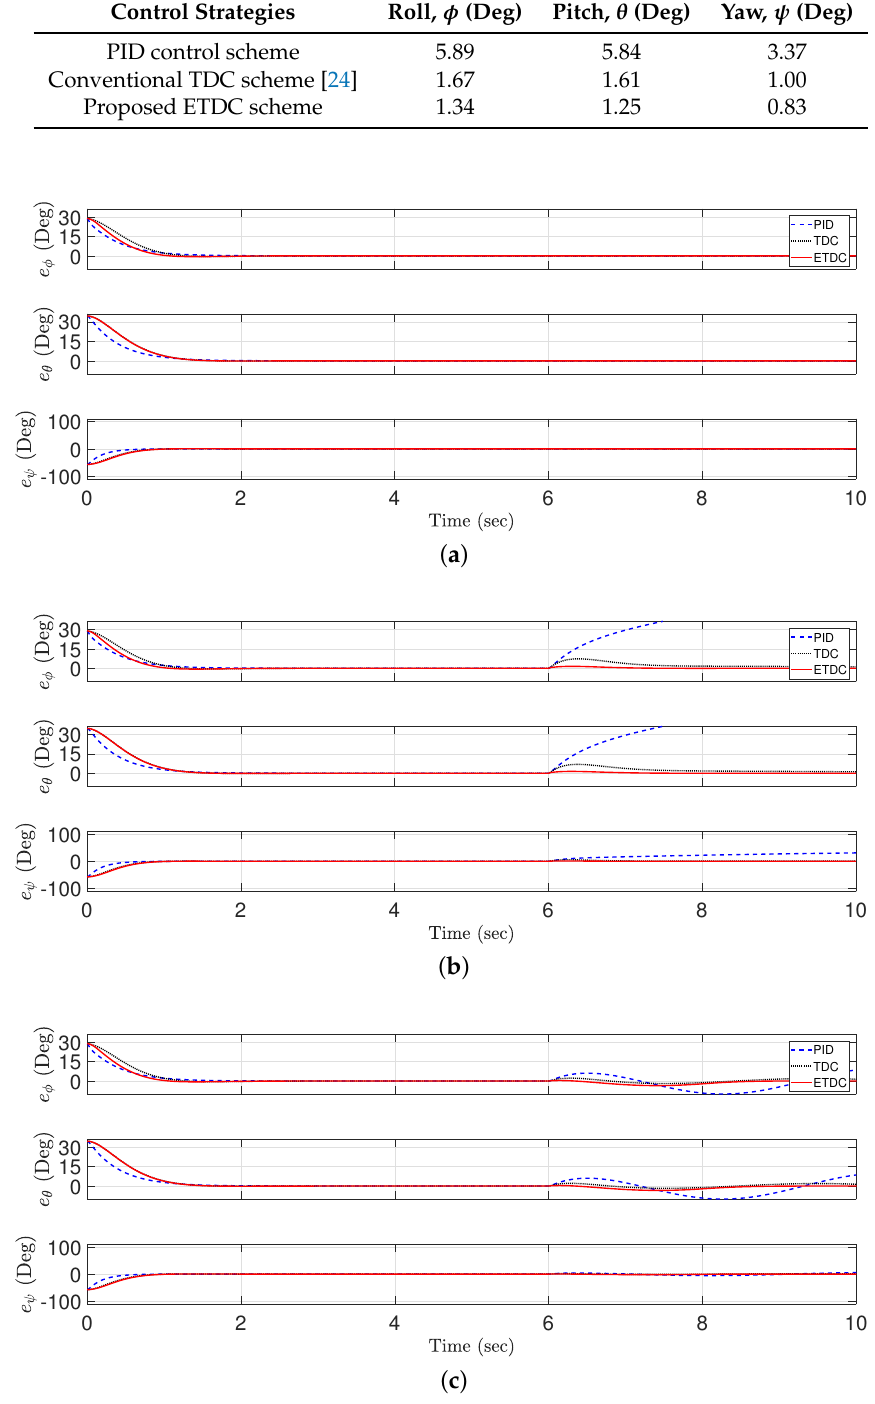
Figure 5. Comparison of the trajectory-tracking errors of PID control scheme (dotted line), conventional TDC scheme (dashed line), and the proposed ETDC scheme (solid line): ( a ) without ED (C1); ( b ) with ED (one direction) (C2); ( c ) with ED (anomalous direction)